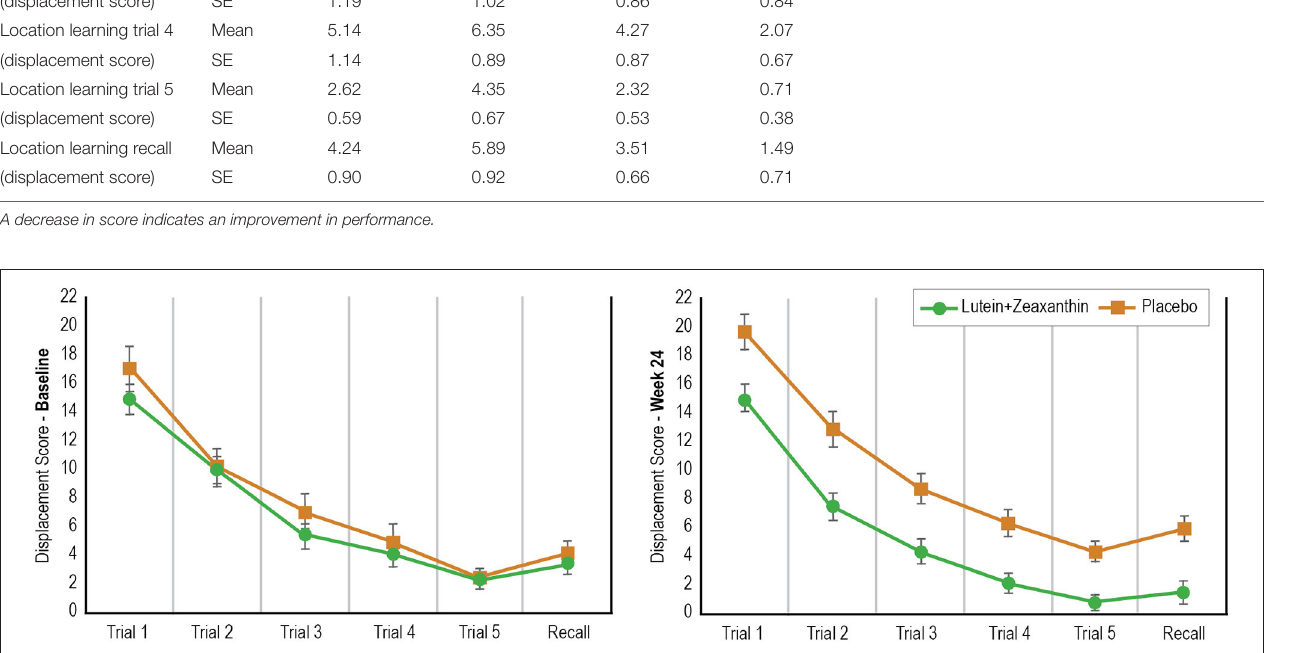
memory and performance have identified in several